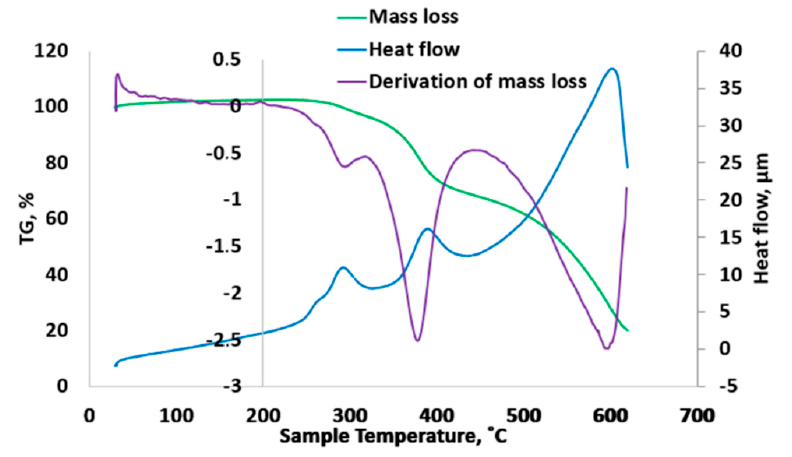
Figure 2. Decomposition characteristics of fibrous electrospun electrode material.